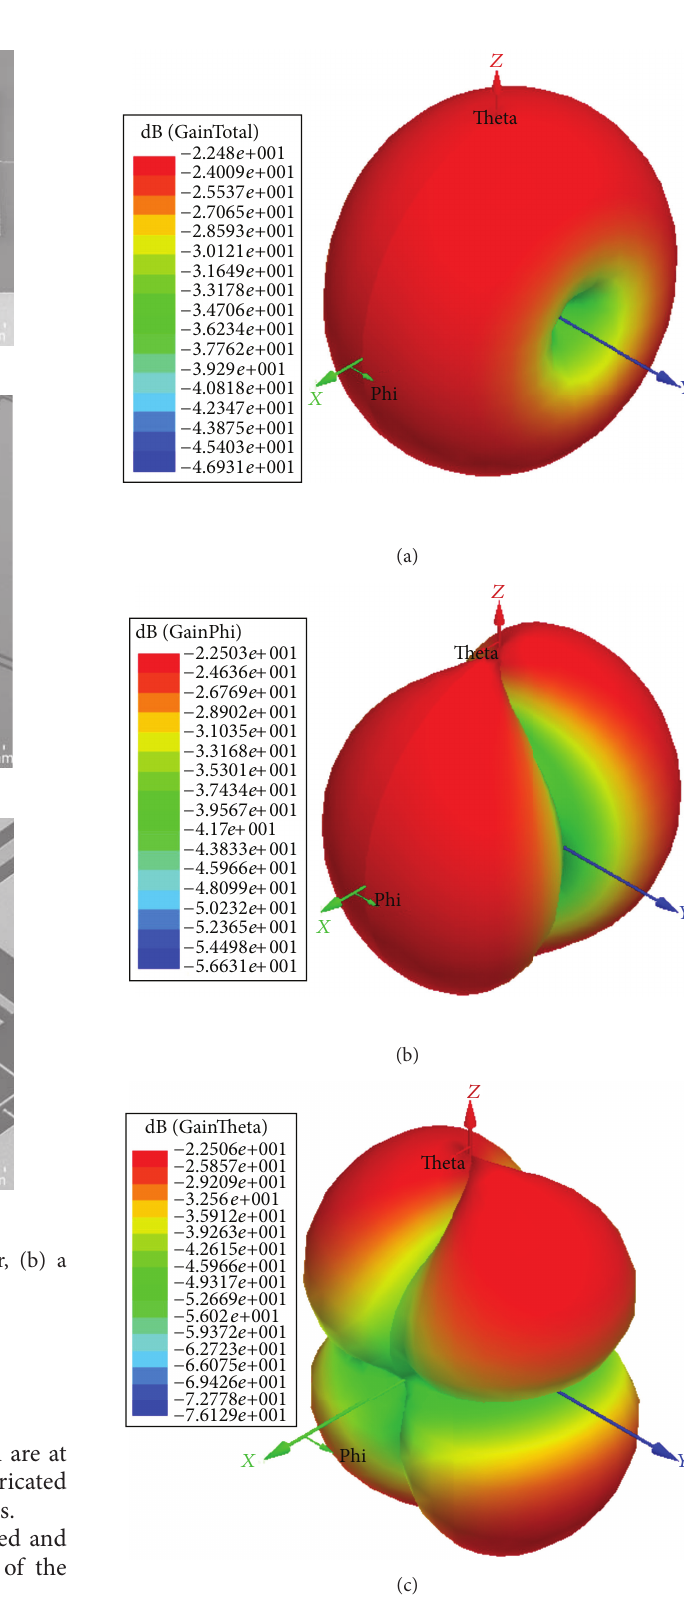
F 10: Simulated far-�eld radiation patterns at 8.4GHz. (a) Total gain, (b) electric-plane gain and (c) magnetic-plane gain for the MEMS-MTM